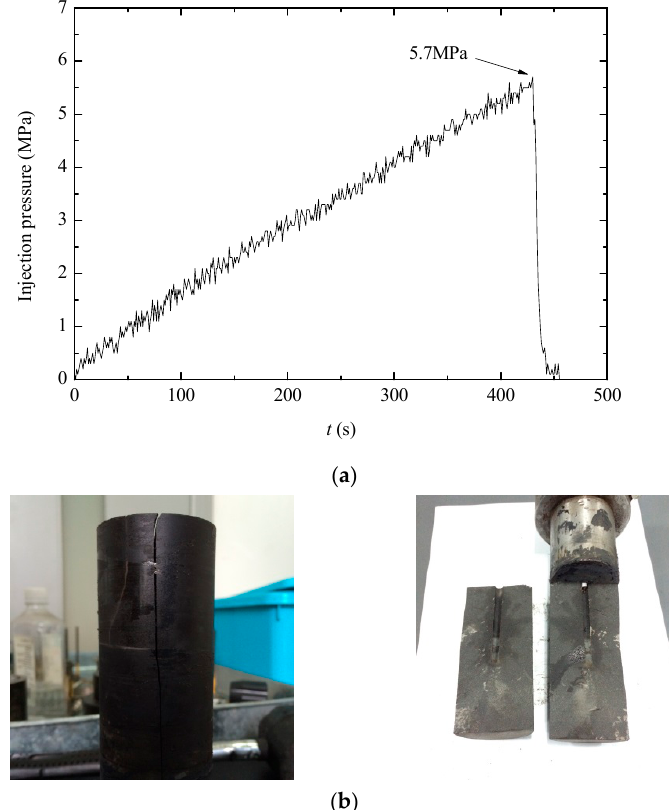
Figure 4. Experimental results of the shale sample during nitrogen fracturing. ( a ) Pressurization history; and ( b ) Failure pattern.